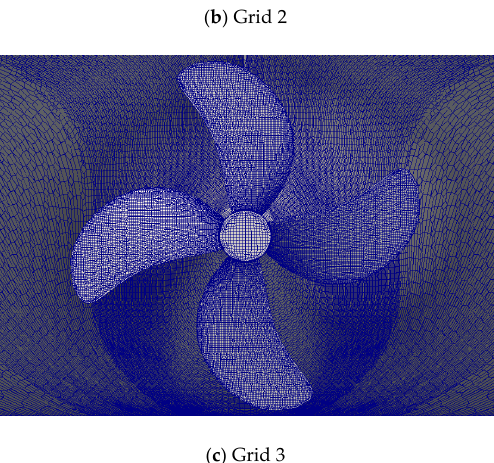
Figure 5. The surface mesh of ship stern and propeller.